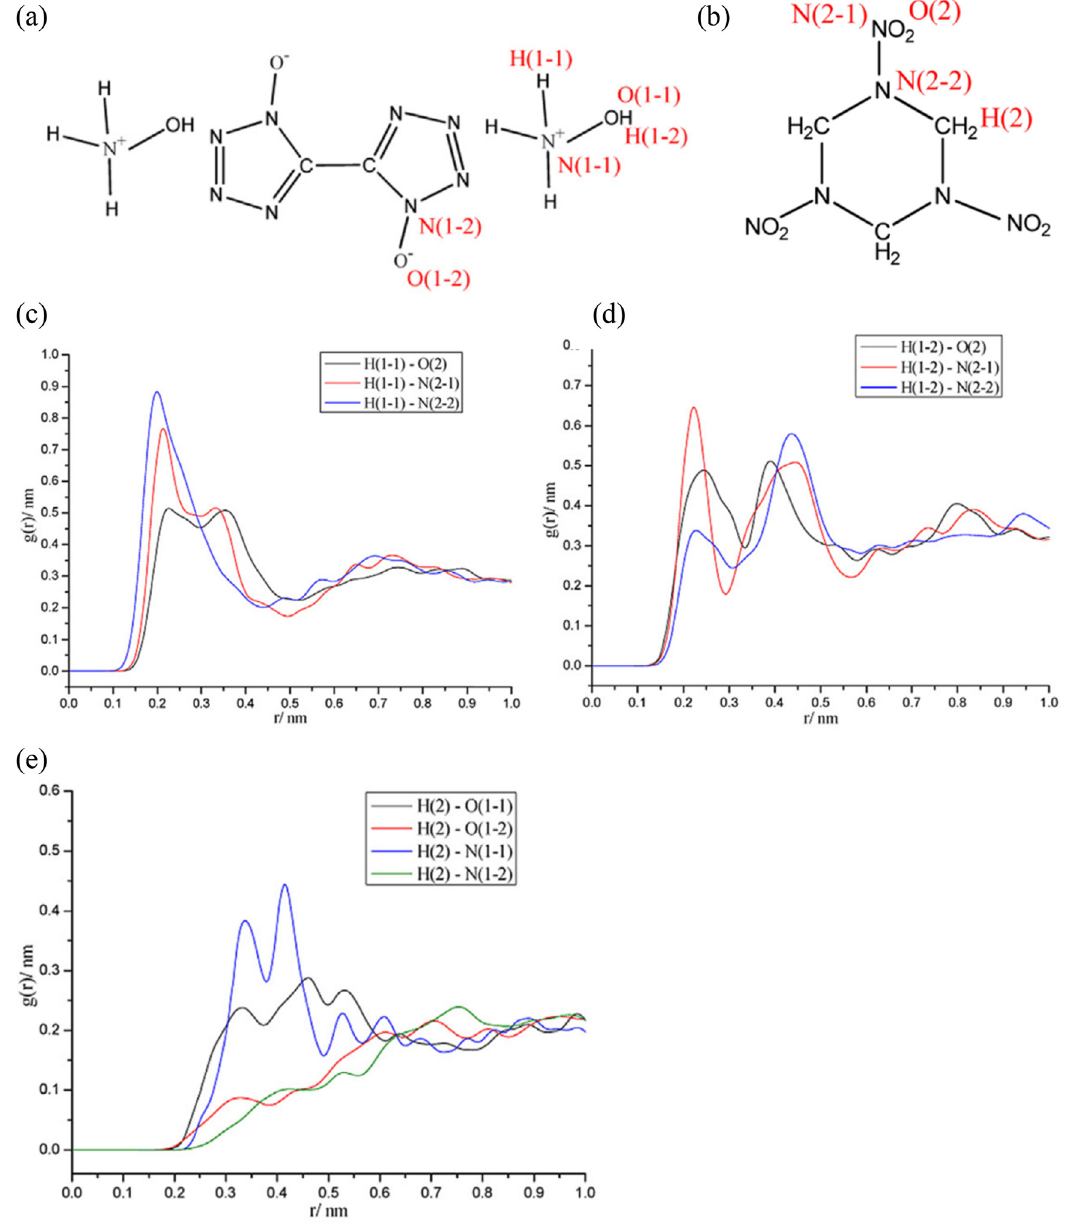
Figure 3: Explanation of hydrogen bonds in TKX - 50/RDX cocrystal. ( a ) Molecular structure of TKX - 50. ( b ) Molecular structure of RDX. ( c – e ) RDF spectra of di ff erent types. H, O, N atoms of TKX - 50 were recorded as H ( 1 - 1 ) , H ( 1 - 2 ) , O ( 1 - 1 ) , O ( 1 - 2 ) , N ( 1 - 1 ) , and N ( 1 - 2 ) ; H, O, N atoms of RDX were recorded as H ( 2 ) , O ( 2 ) , N ( 2 - 1 ) , and N ( 2 - 2 ) [ 98 ]